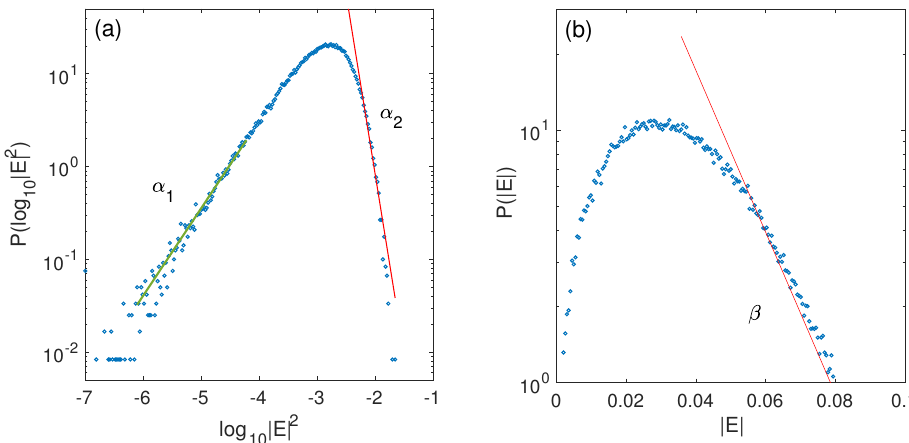
Figure 22. PDFs of the electric fields’ amplitudes averaged over the time interval ∆ T . ( a ) Distribution | E | 2 , with linear fits of slopes α (cid:39) 2.3 and α (cid:39) − 9.7. ( b ) Distribution of | E | , with a linear fit at of log 2 1 10 large | E | of slope β (cid:39) − 5.8. Main parameters are : ∆ n (cid:46) 0.001, n b / n 0 = 5 × 10 − 5 , ∆ T = [ 50,000,60,000 ] . Field and time variables are normalized, but not the PDFs. (Reproduced with permission from